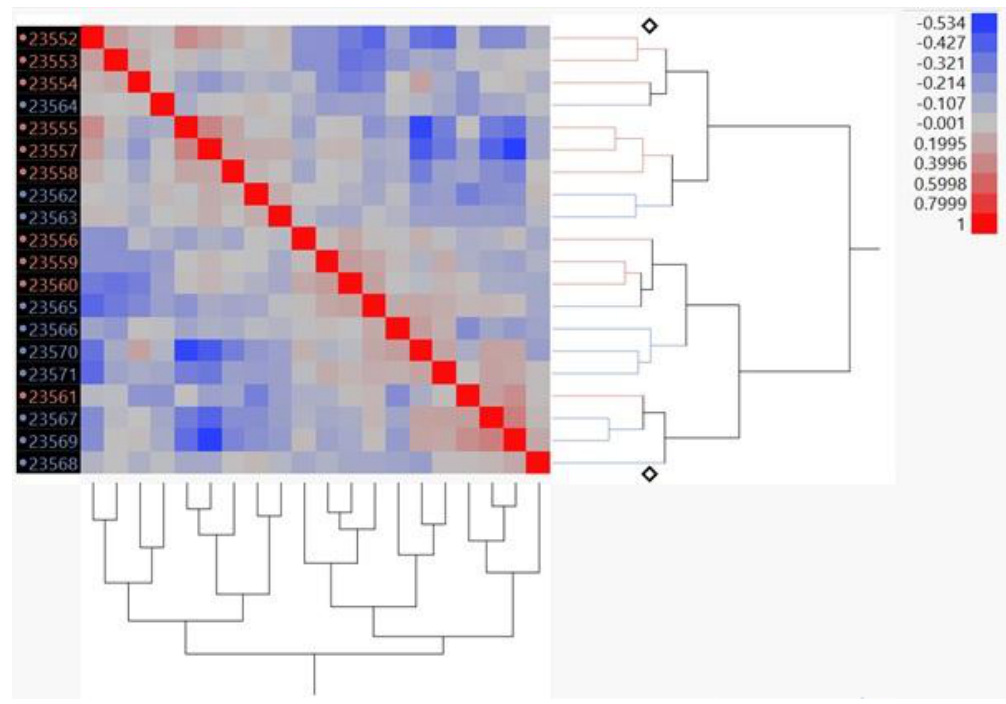
Figure B1. Correlation heat map using transcripts per kilobase million normalization. The heat map represents the graphical display resulting from unsupervised clustering of the correlations between samples. The x - and y -axis are the same and the red diagonal line represents a correlation of 1. The pink labeled IDs are associated with the soybean diet while the blue labeled IDs are from the corn oil diet. Nutrients 2019 , 11 , x FOR PEER 17 of 19